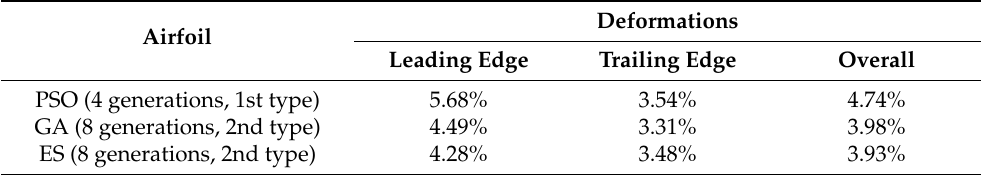
Table 2. Deformations of the LE and TE regions and of the total geometry (length increase with respect to the original geometry) for the derived airfoils of first and second